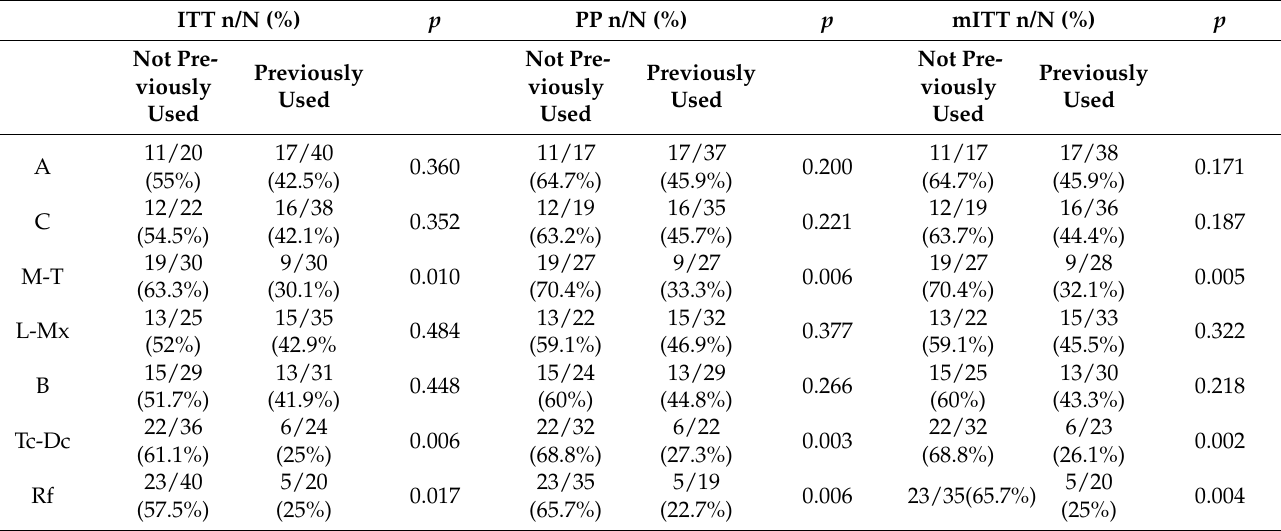
Table 3. Comparison of HDDT effectiveness by previous antibiotic prescriptions.